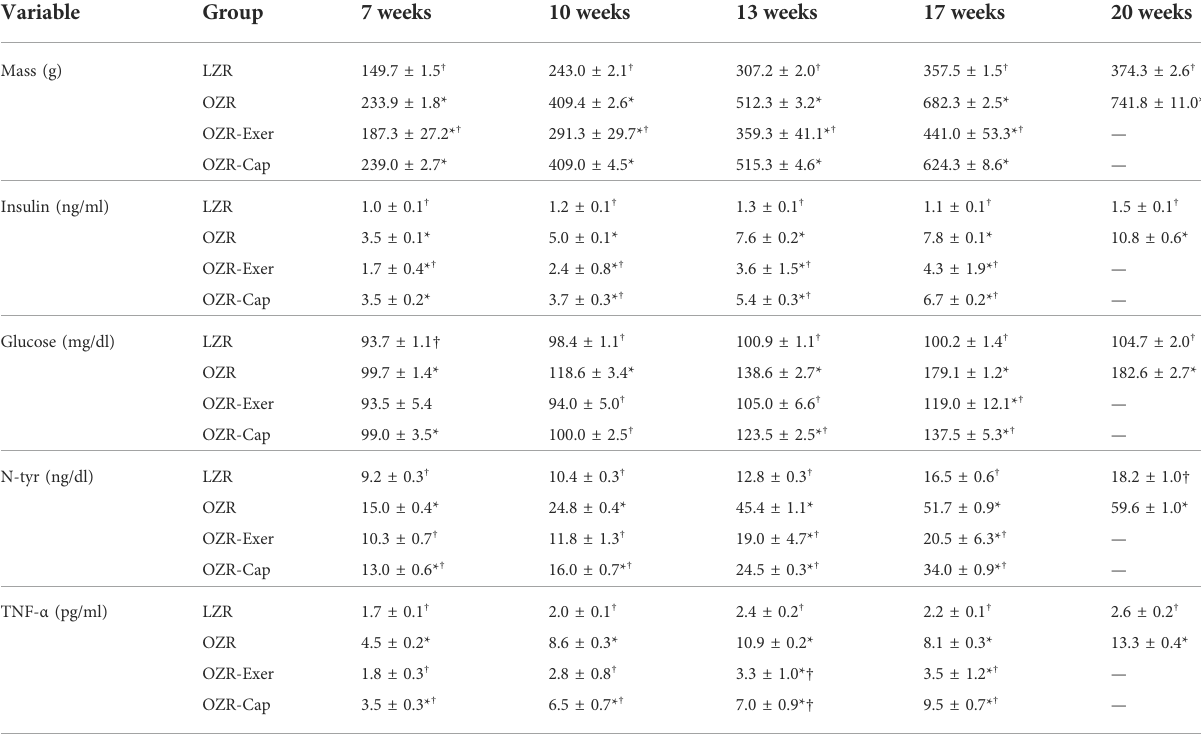
TABLE 3 Baseline characteristics of animals used in the present study.